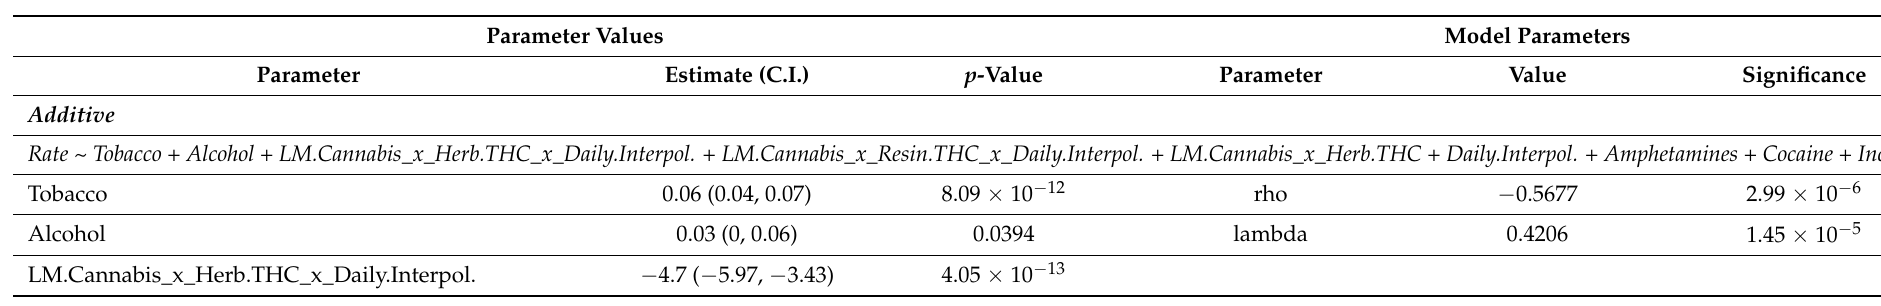
Table 2. Geotemporospatial Regressions for Uronephrological Congenital Anomalies as a